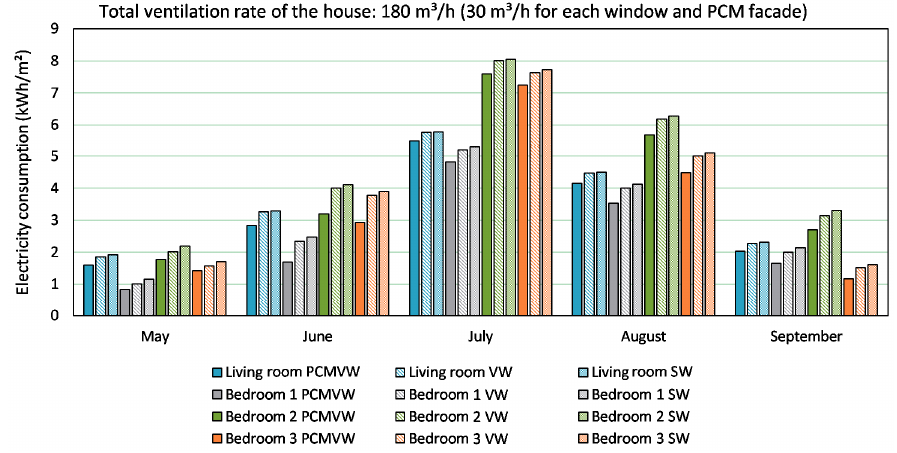
Figure 13. The heat pump electricity consumption of each room during the summer period at a ventilation airflow rate of 180 m 3 /h.